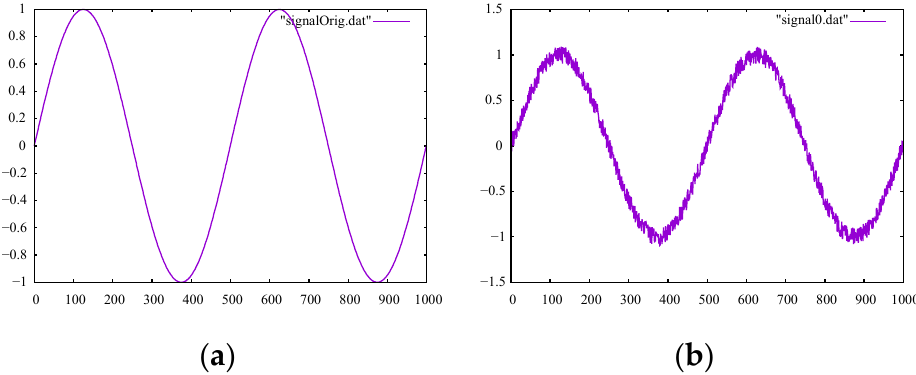
Figure 1. ( a ) The experimental true sine signal of frequency 1 and ( b ) the sine signal with randomly generated noise added.